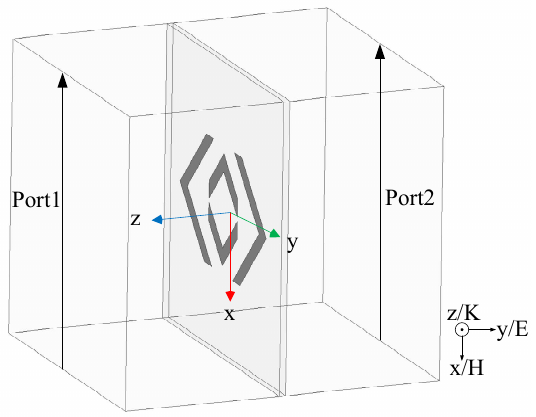
Figure 4. HFSS simulation model of temperature sensor.